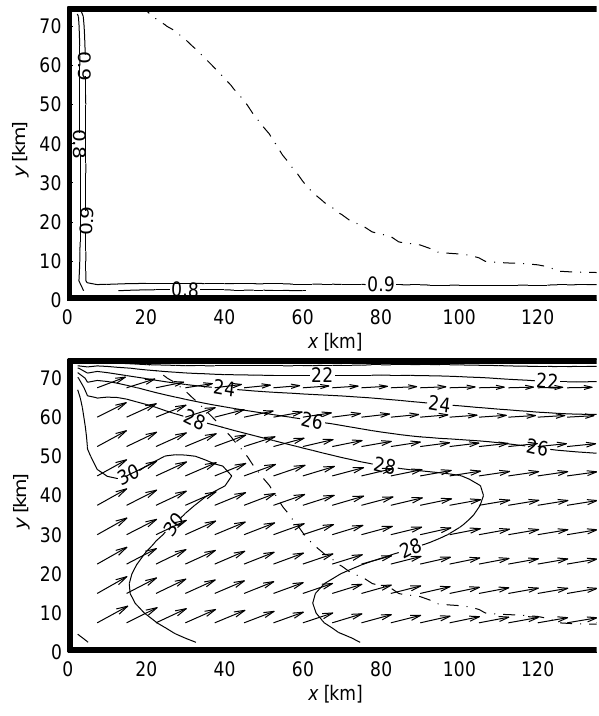
Fig. 9. The ice concentration ( A , top) and speed and velocity ( v and | v | , bottom) using h 0 =10cm after eight model days. The resulting polynya is smaller and has a higher ice concentration than the con- trol run. The dash-dotted line shows the isoline for A =0.8 from the control run.